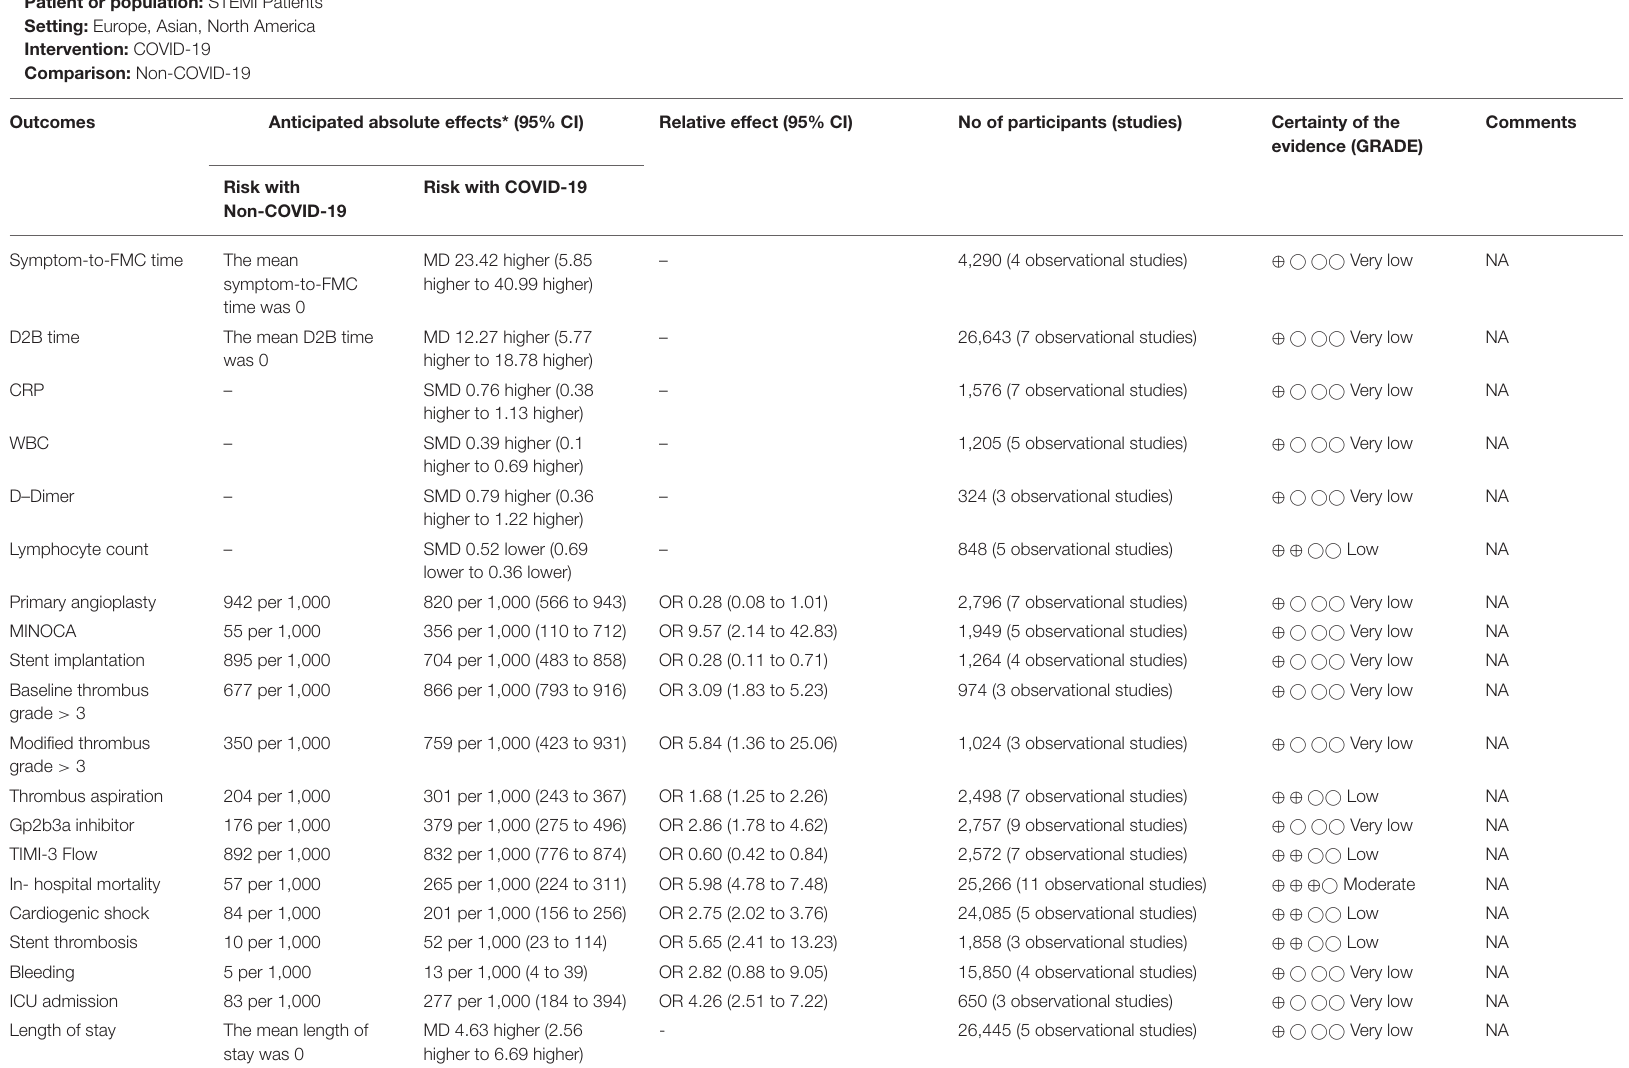
TABLE 3 | GRADE summary of findings. Effects of COVID-19 in STEMI patients Patient or population: STEMI Patients Setting: Europe, Asian, North